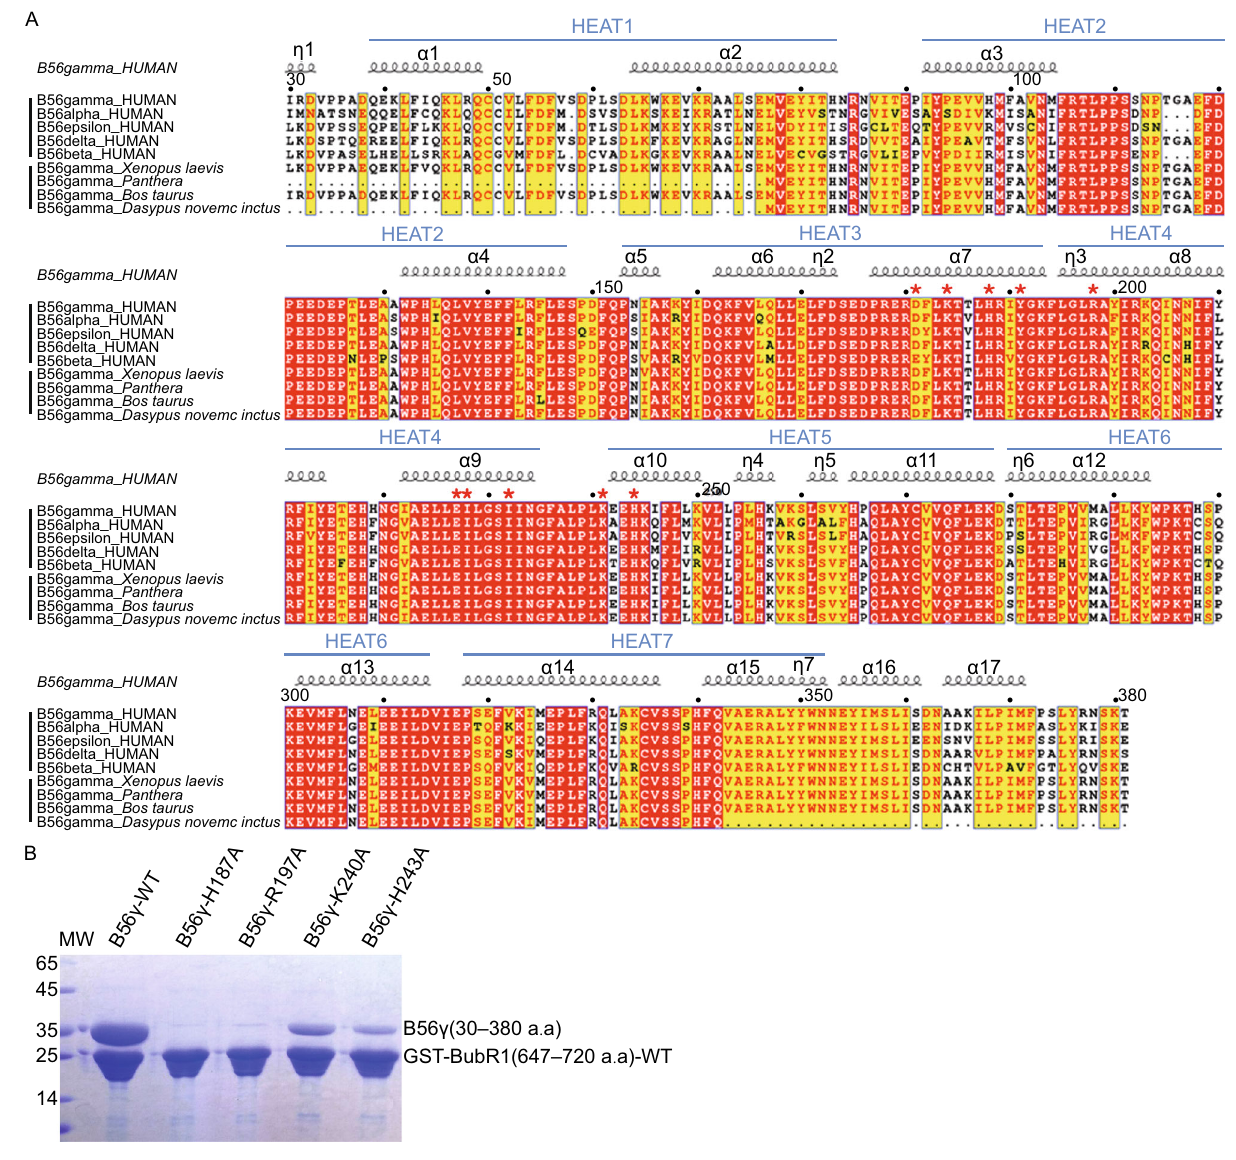
Figure 3. Sequence alignment of B56 γ 1 and mutagenesis of B56 γ 1. (A) B56 sequence alignment. The upper half shows the alignment of the fi ve different human B56 isoforms, whereas the lower half demonstrates the sequence conservation of B56 γ from different organisms. Numbers above indicate amino acid position based on the sequence of human B56 γ 1. B56 γ has three isoforms with different C-terminal domains. Only B56 γ 1 is shown here. The strictly conserved residues are in white letters with red background and the conserved residues are in red letters with yellow background. Residues involved in BubR1 interaction are indicated with red asterisks. (B) Pulldown of mutant B56 γ 1 proteins by WT GST-BubR1(647 –